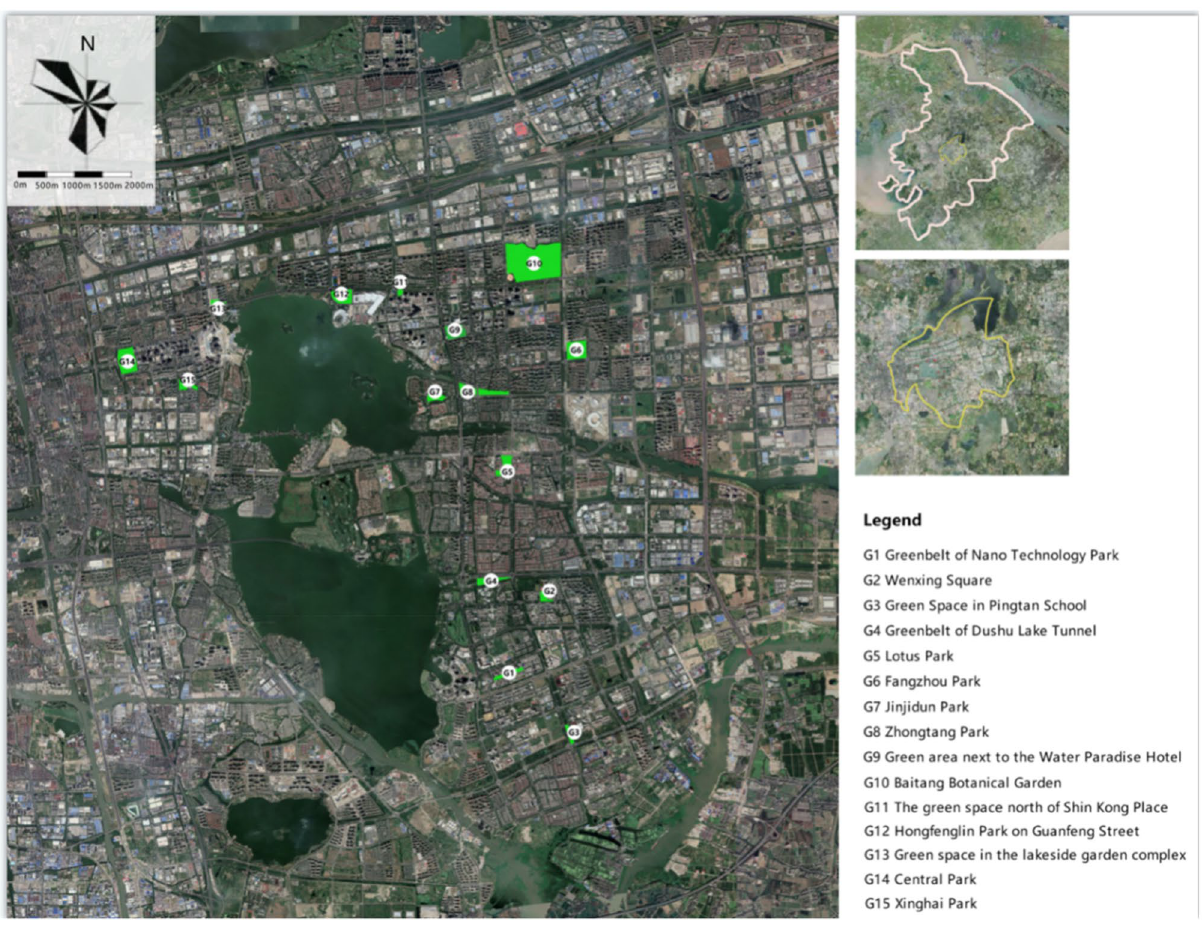
Figure 1. Plot layout and geometry (Source: Maps Data: Baidu©2022 DigitalGlobe,